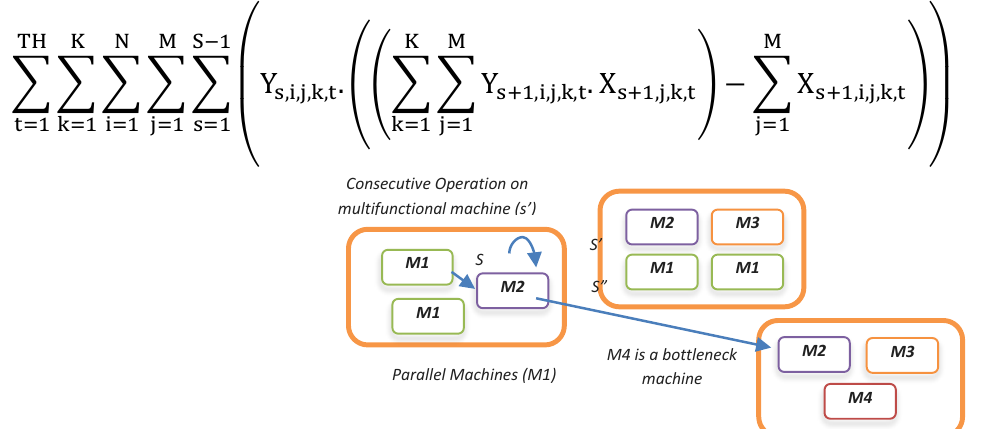
Fig. 2. Graphical scheme of inter and intra-cellular